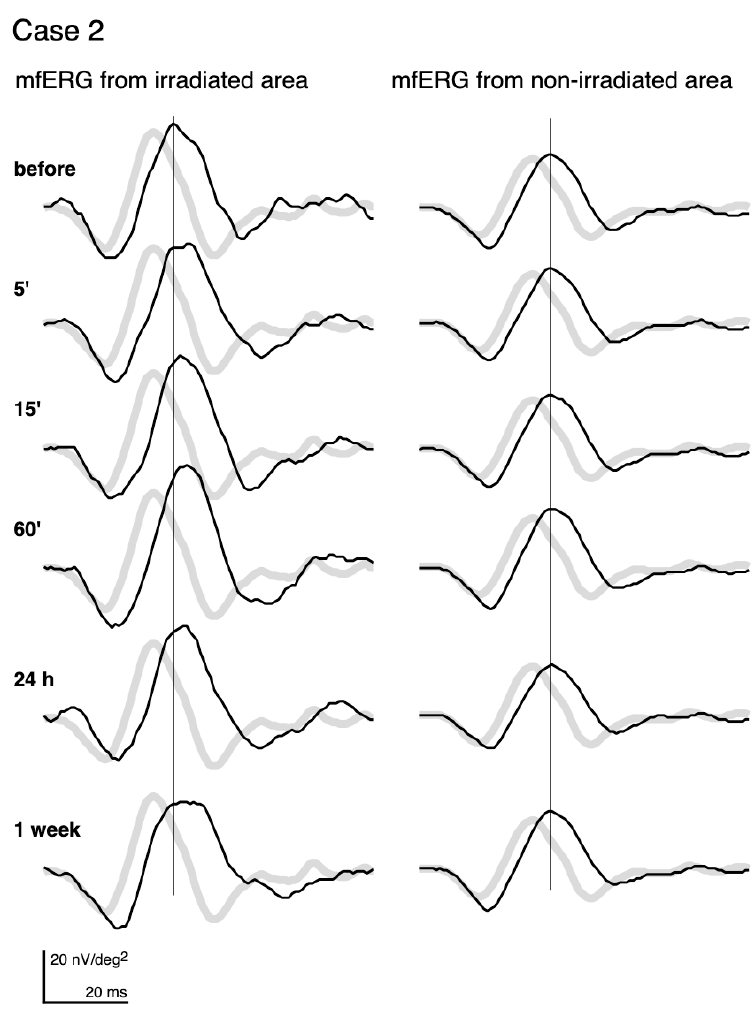
Figure 2. mfERGs recorded before and at different times after photocoagulation (PC). mfERGs from the irradiated area ( left ) and from the non-irradiated area ( right ) of Case 2 (same case as Figure 1) are shown. The pale curves represent the averaged normative mfERGs obtained from 8 healthy volunteers at the same loci. Even before PC, the mfERGs from both the irradiated area and non-irradiated area had longer implicit times relative to the normative mfERGs. We assume that this is due to diabetes or DR. This pre-irradiation delay was commonly observed. The delay was more than 0.83 ms of the implicit time of the first positive peak in all subjects for the mfERG recorded from the irradiated area. In addition, the delay was found in the mfERGs rec- orded from the non-irradiated areas in 13 of the 15 subjects. After PC, the mfERGs from the non-irradiated areas (right column) did not show any changes throughout the recordings. Statistical analyses of the average and each individual